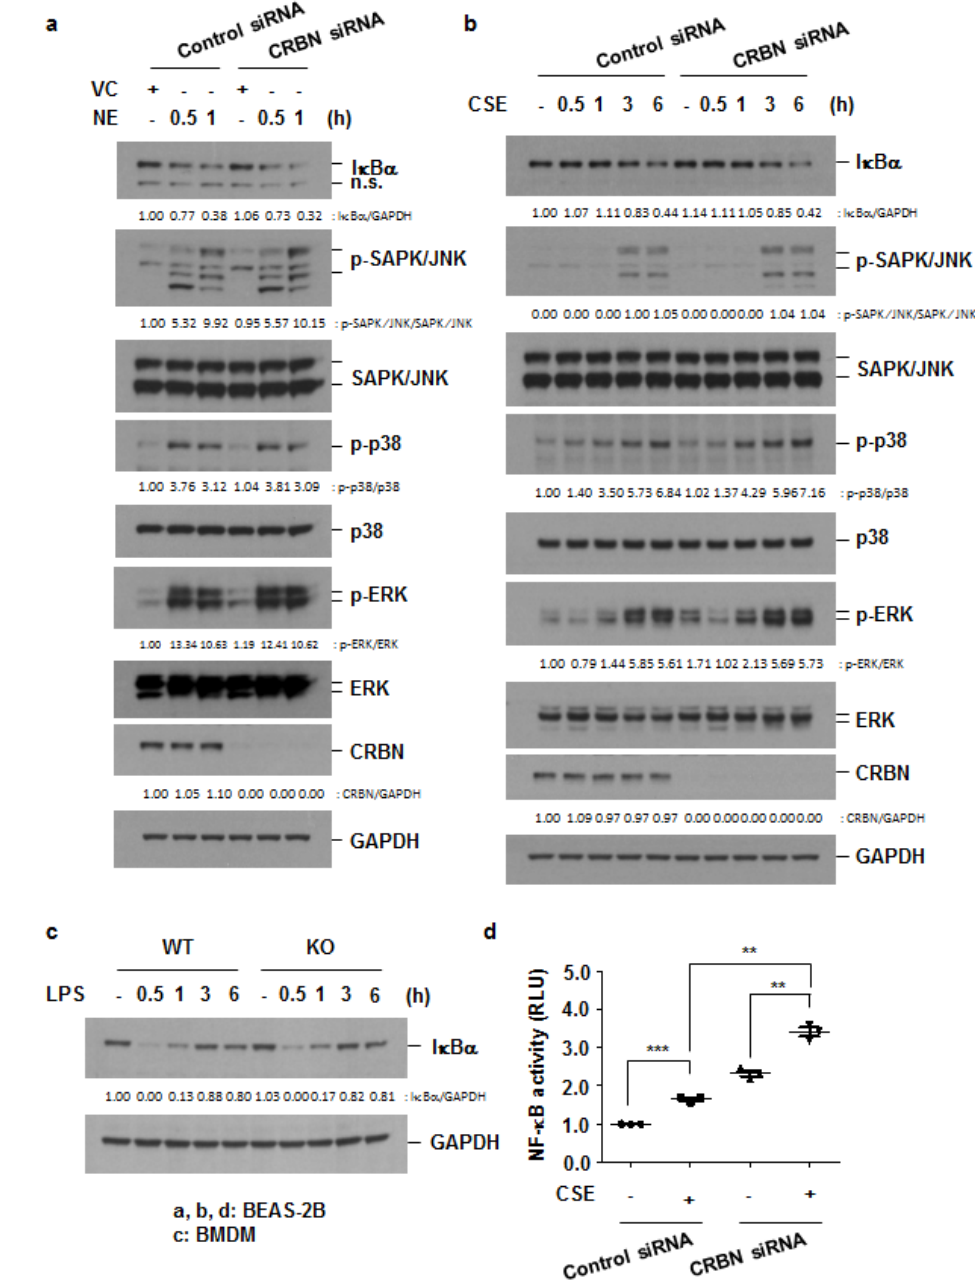
Figure 5. Crbn KO enhanced inflammatory cytokine/chemokine production by increasing NF- κ B activation. ( a , b ) BEAS-2B cells were transiently transfected with control siRNA or Crbn siRNA. Forty-eight hours after transfection, the cells were treated with VC or NE (1 U/mL) ( a ) and CSE (1%) ( b ) for the indicated times. Total cell lysates were subjected to Western blot analysis for I κ B α , p-SAPK/JNK, total SAPK/JNK, p-p38, total p38, p-ERK, total ERK, CRBN, and GAPDH. ( c ) WT and Crbn KO BMDMs were stimulated with LPS (100 ng/mL) for the indicated times. Total cell lysates were subjected to Western blot analysis for I κ B α and GAPDH. ( d ) BEAS-2B cells were co-transfected with the NF- κ B-luciferase reporter construct, control plasmid, control siRNA, and Crbn siRNA using the Neon electroporation kit. Forty-eight hours after transfection, cells were treated with CSE (1%) for 24 h. Luciferase activity was detected and normalized with Renilla activity. Data represent the mean ± SD. ** p < 0.01, and *** p < 0.001.